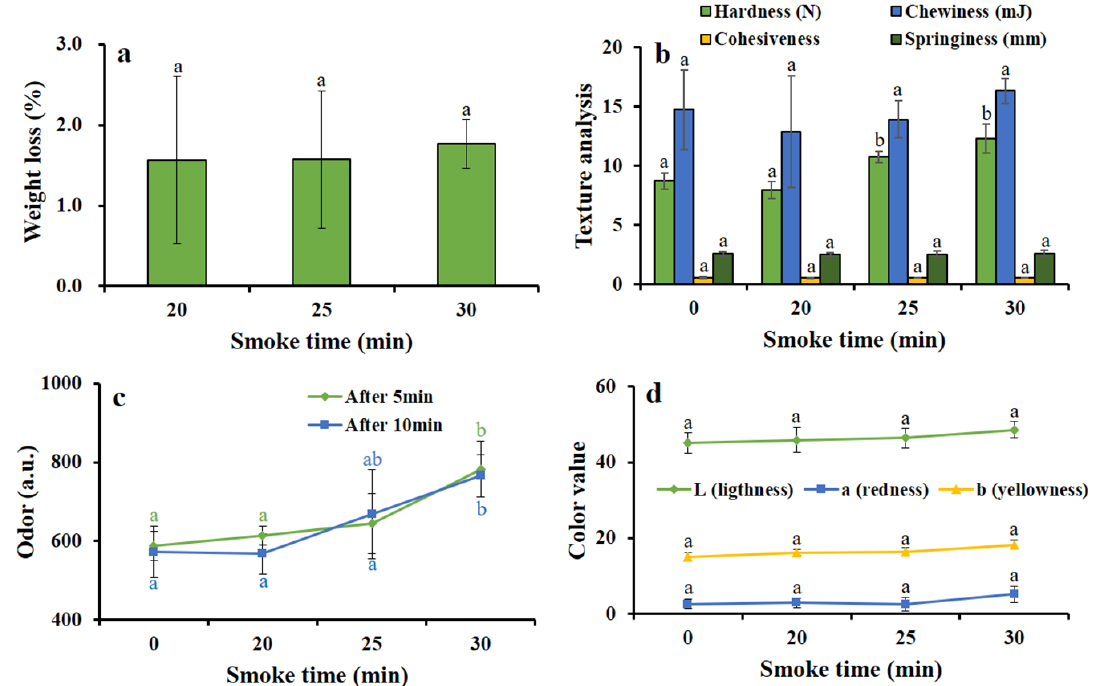
Figure 3. Different smoking times on the effects of ( a ) weight loss, ( b ) texture analysis, ( c ) odor (a.u.), and ( d ) color value of hot smoked HDPS. Data represent the mean ± std of 10 observations, where groups not sharing a letter are expressed as significantly different ( p < 0.05).